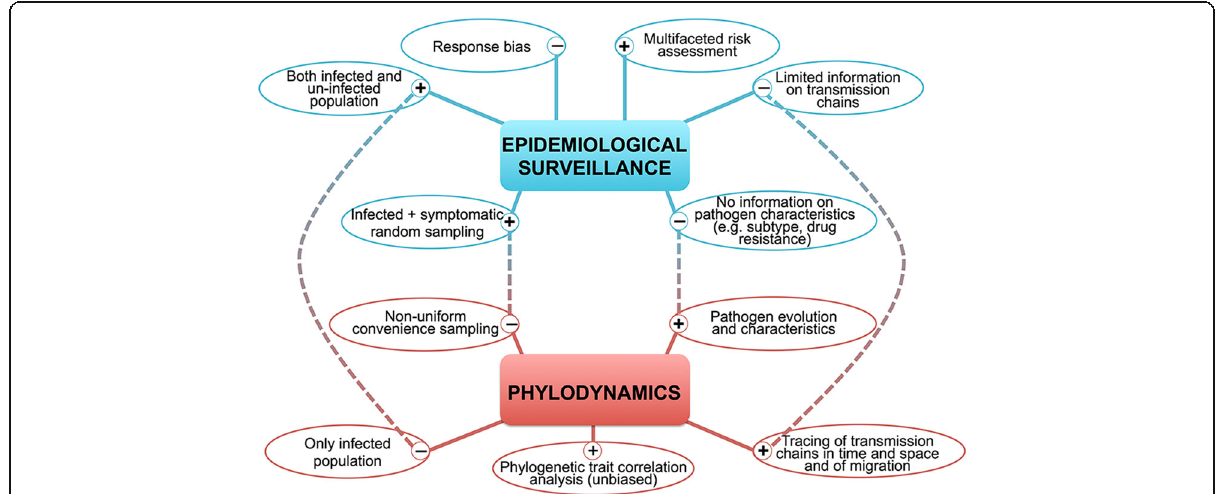
Fig. 1 Benefits and limitations of epidemiological surveillance and phylodynamic methods employed for control of infectious